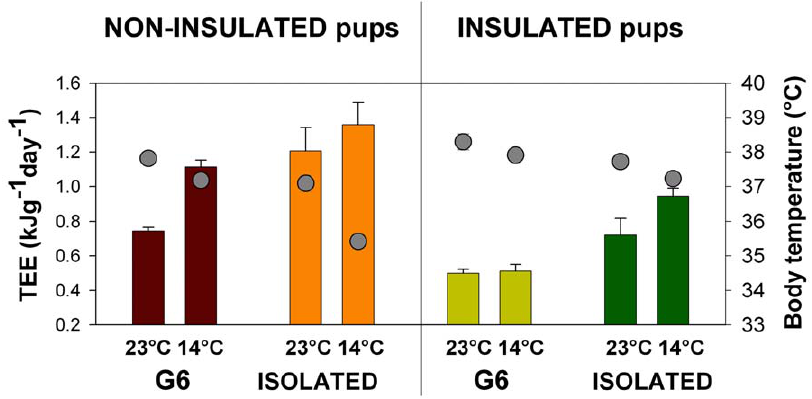
Figure 2. Total energy expenditure (TEE, kJg 2 1 day 2 1 ; bars) and body temperature ( 6 C; circles) for each pup category (G6 huddling and G1 isolated pups, insulated and non-insulated, exposed at 23 6 C and 14 6